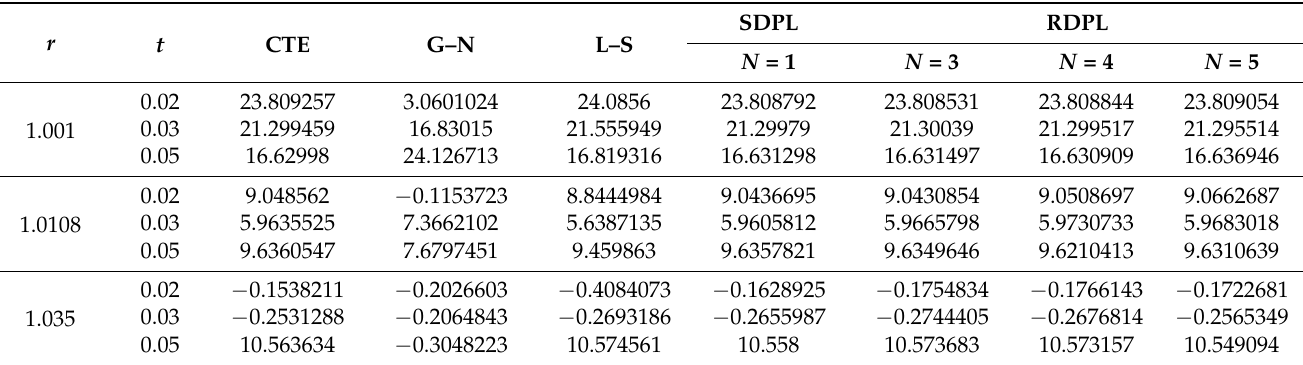
Table 1. Effects of dimensionless time t on volumetric strain e according to different thermoelasticity theories with several values of r .